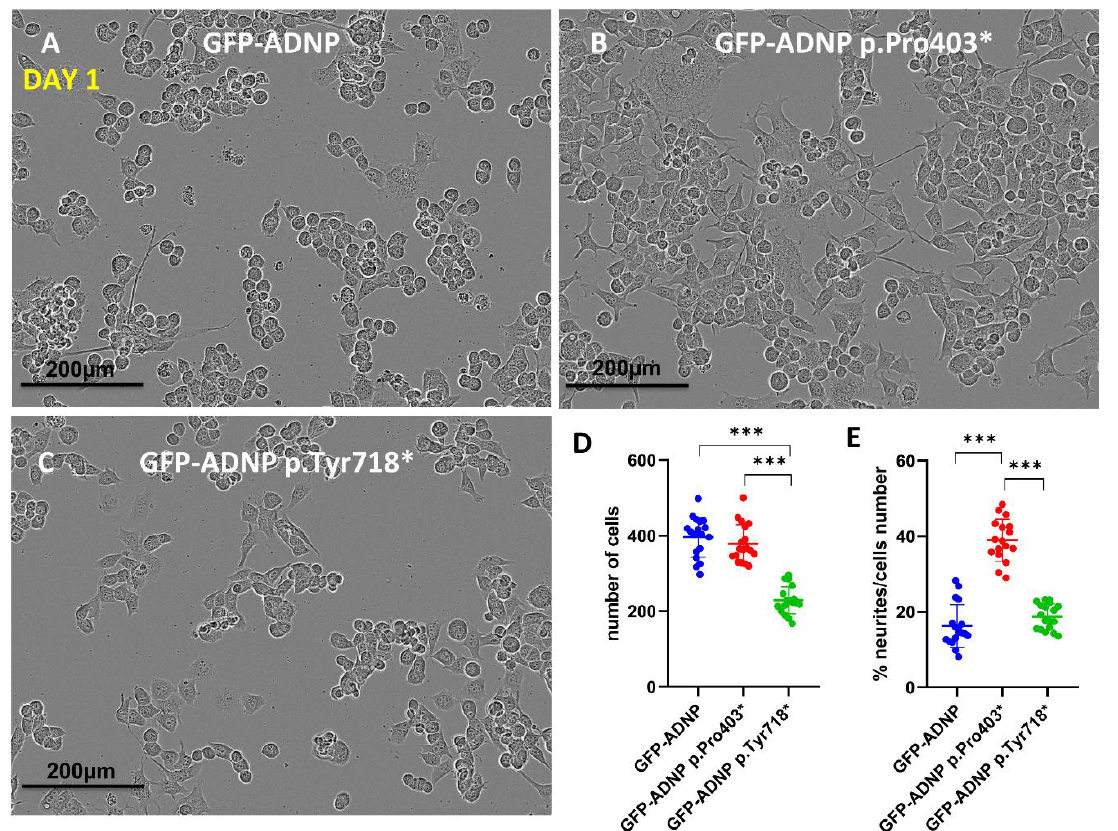
Figure 2. IncoCyte images and analysis indicate differential effects of selected ADNP mutants. ( A ) Neuroblastoma cell lines expressing full-length ADNP or ( B , C ) truncated ADNP proteins were scanned with IncoCyte (×20) following a 24 h incubation in differentiation medium. Image size (1408 × 1040 pixels), represents one field, with 20 fields being analyzed for each condition. ( D ) When the number of counted cells per field (N = 20) was analyzed statistically, significant cell death in the GFP-ADNP p.Tyr718*-expressing line was revealed, *** p < 0.001. ( E ) Calculating the percentage of neurites in each field showed increased neurite levels in cells expressing GFP-ADNP p.Pro403*.